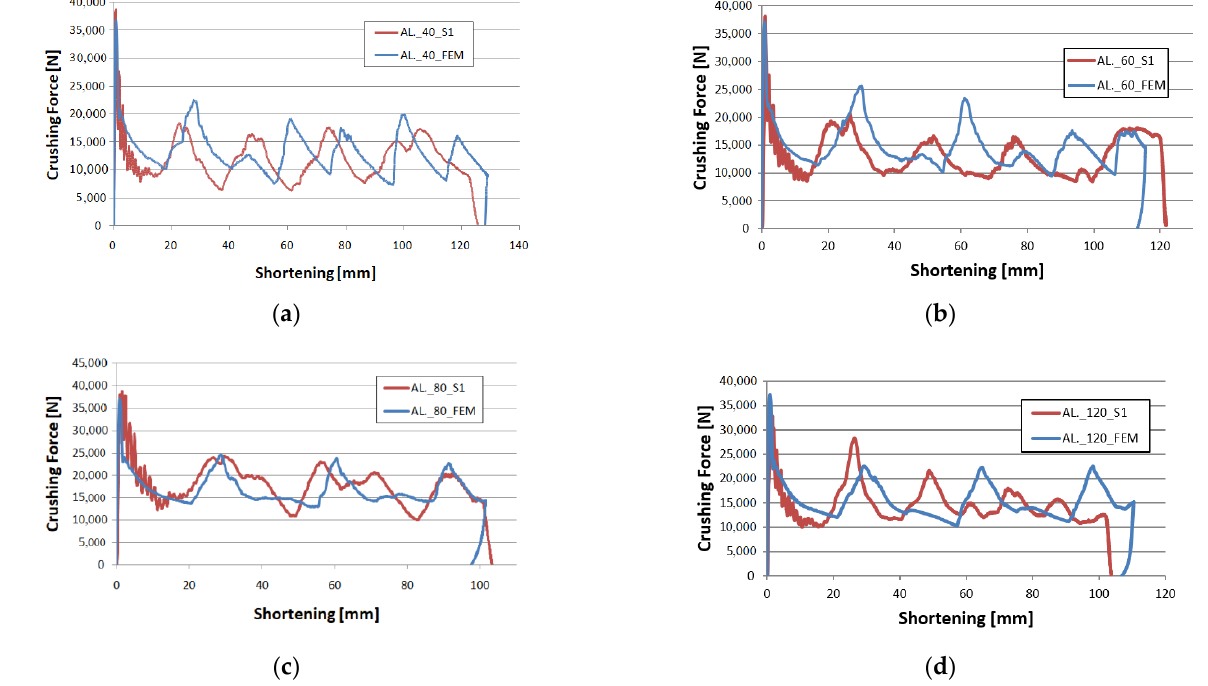
Figure 10. Experimental and numerical force-shortening diagram: ( a ) column with 40 mm foam filling; ( b ) column with 60 mm foam filling; ( c ) column with 80 mm foam filling; ( d ) column with 120 mm foam filling.